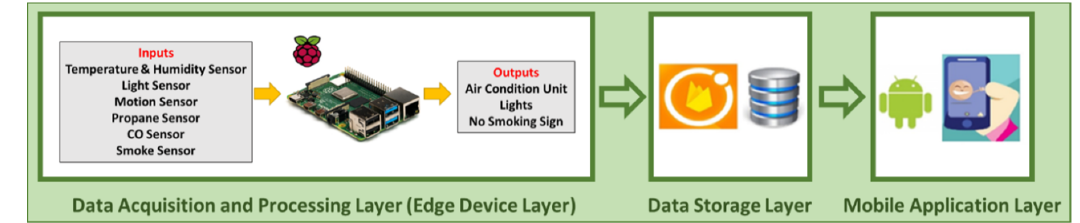
Figure 1. The hardware layers of the proposed system.